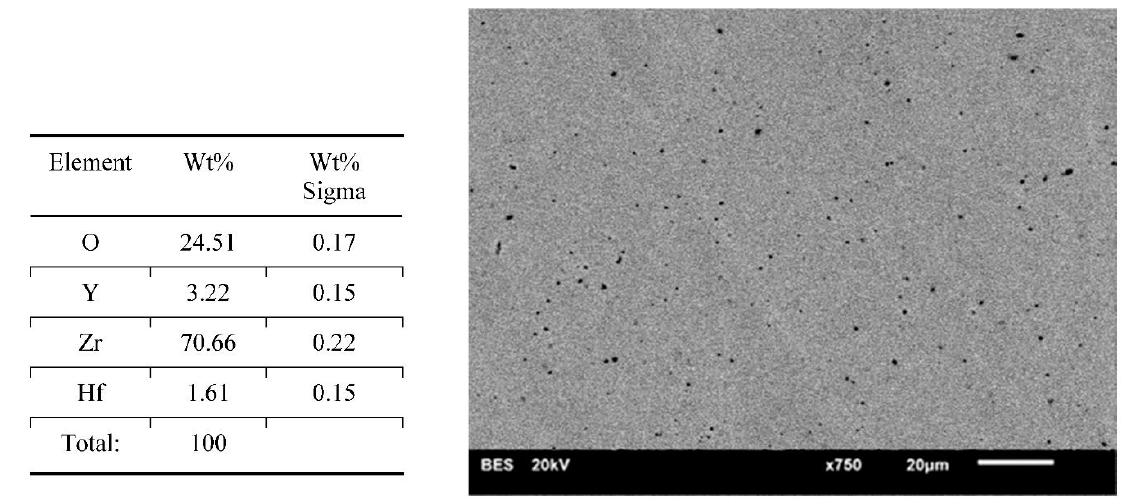
Figure 7. Chemical composition of the presented area and a backscattered electron image of a sample—wet ground 500 grit paper. Lots of small splintering of the material with small and less visible features.